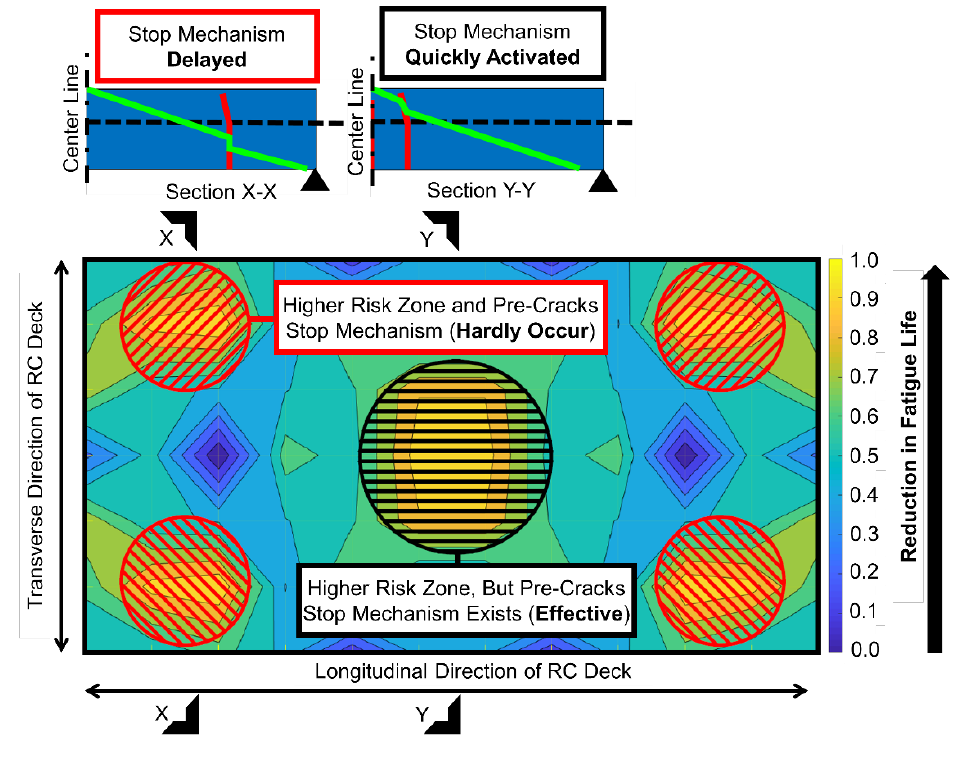
Figure 22. Hazard map for the locations of higher risk cracking.